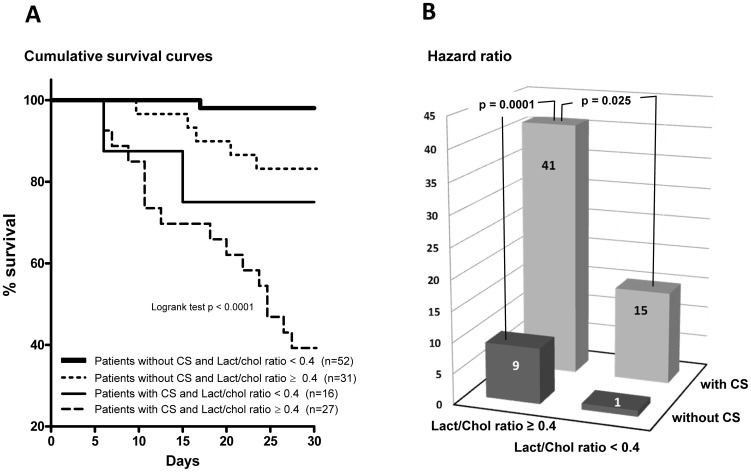
Survival analysis of the training cohort by the combination of clinical presentation and lactate to cholesterol ratio.(A) Kaplan Meier survival curves for patients with AHF of the training cohort stratified into 4 groups based on the combination of clinical presentation (with or without cardiogenic shock (CS)) and the cutoff level of lactate to cholesterol ratio (Lact/Chol ratio). (B) Usefulness of 30-day mortality prediction using Lact/Chol ratio and clinical presentation. Hazard ratio with referent group (i.e. without CS and a Lact/Chol ratio < 0.4) for «Lact/Chol ratio ≥ 0.4 — without CS», 9 (p = 0.015); for « Lact/Chol ratio < 0.4 — with CS», 15 (p = 0.0014) and for « Lact/Chol ratio ≥ 0.4 — with CS», 41 (p<0.0001).